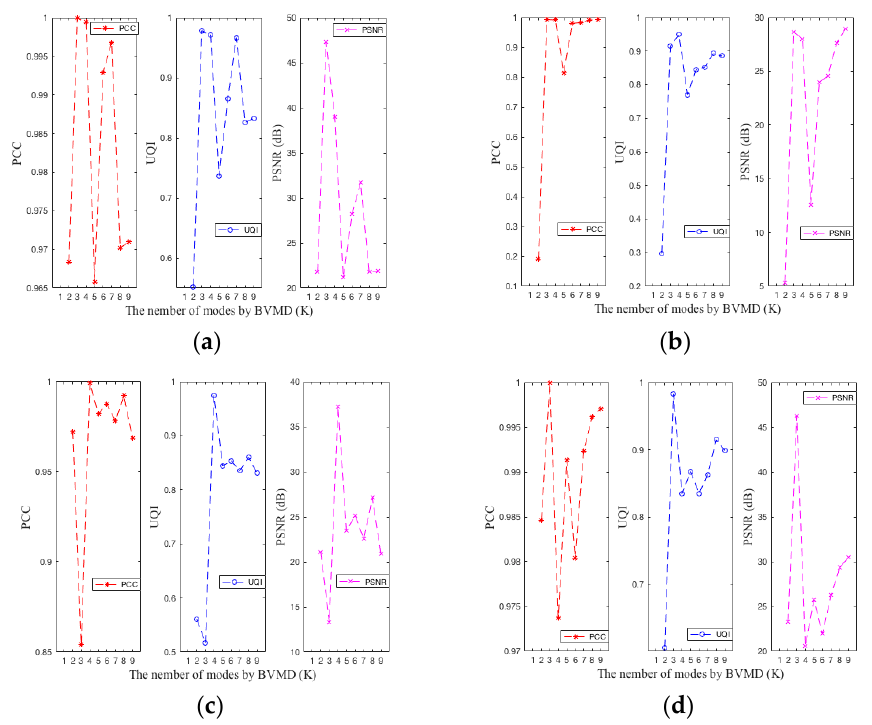
Figure 8. Three indicators of PCC , UQI , and PSNR of 2D echo signal reconstruction of four different types of UWB radar-based human motion 2D echo analysis signal. ( a ) The three indicators of PCC , UQI , and PSNR of 2D echo signal reconstruction of walk forward of UWB radar-based human motion 2D echo analysis signal. ( b ) The three indicators of PCC , UQI , and PSNR of 2D echo signal reconstruction of fall forward of UWB radar-based human motion 2D echo analysis signal. ( c ) The three indicators of PCC , UQI , and PSNR of 2D echo signal reconstruction of walk around of UWB radar-based human motion 2D echo analysis signal. ( d ) The three indicators of PCC , UQI , and PSNR of 2D echo signal reconstruction of jump forward of UWB radar-based human motion 2D echo analysis signal.